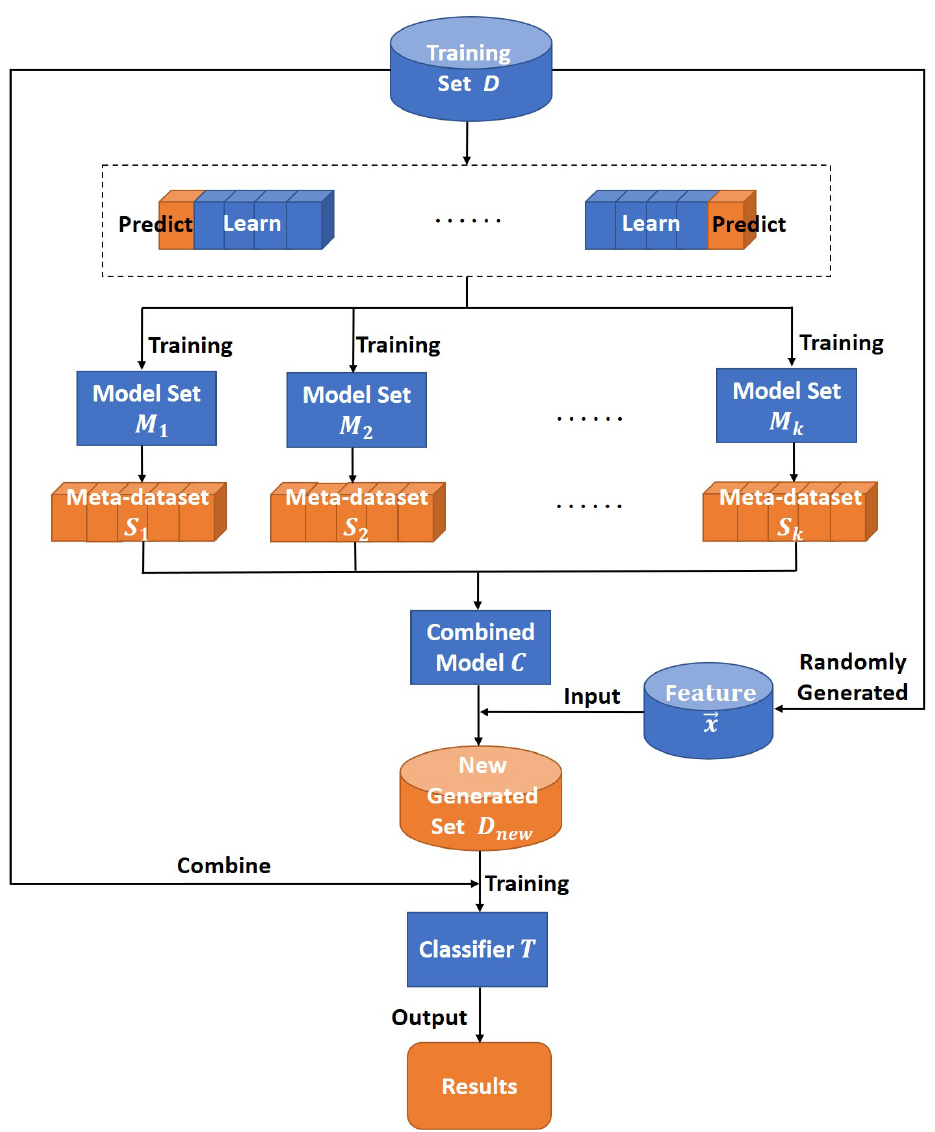
Figure 3. The overall procedure of the MEDT